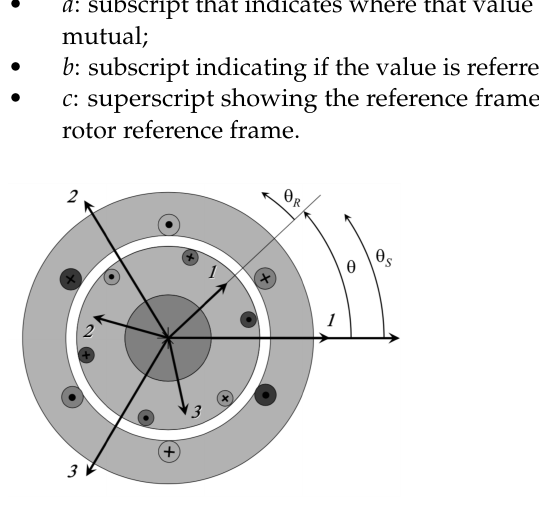
Figure 1. Three-phase Induction machine